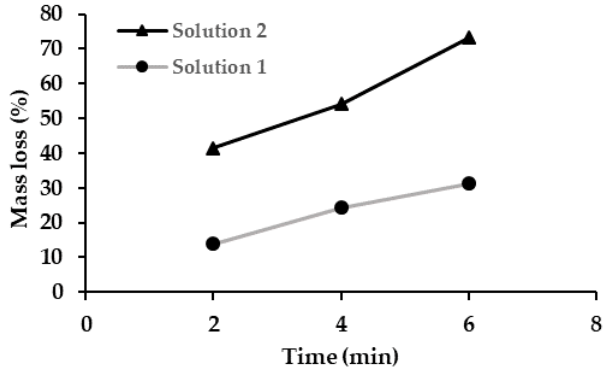
ff erent etching